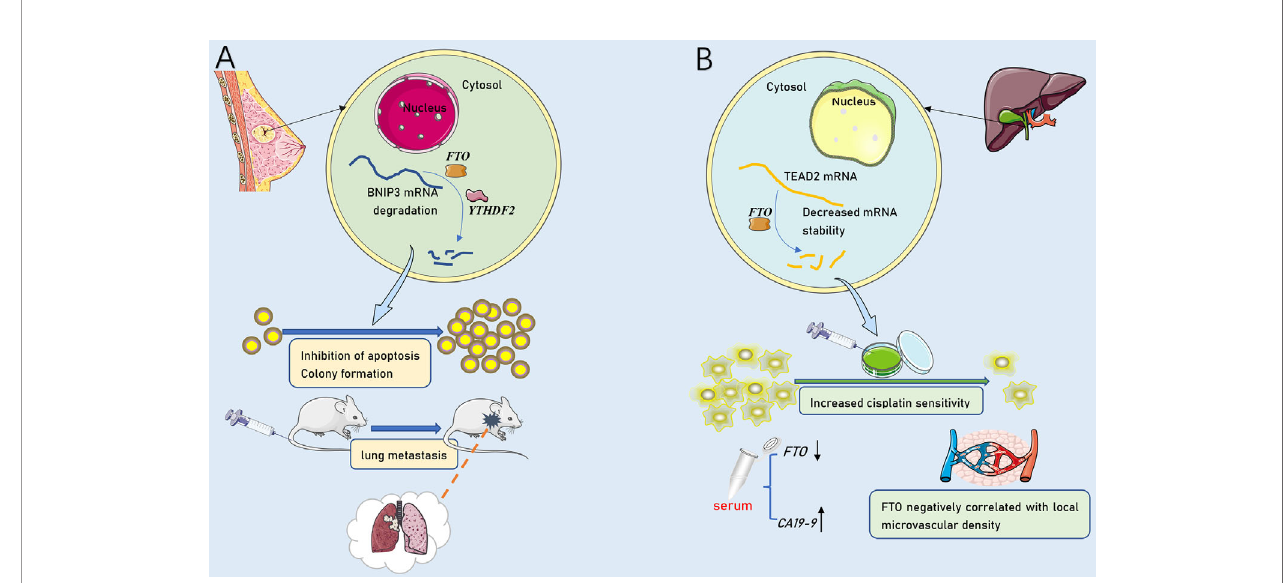
FIGURE 3 | The dual role of FTO in tumor metastasis. (A) As an oncogenic molecule, FTO dramatically promoted breast cancer cell proliferation, colony formation and metastasis by down-regulating BNIP3. (B) As an anti-tumor molecule, FTO down-regulated TEAD2 mRNA stability and promoted cisplatin-induced ICC cell line apoptosis. FTO expression was negatively correlated with serum CA19-9 and local tumor microvascular